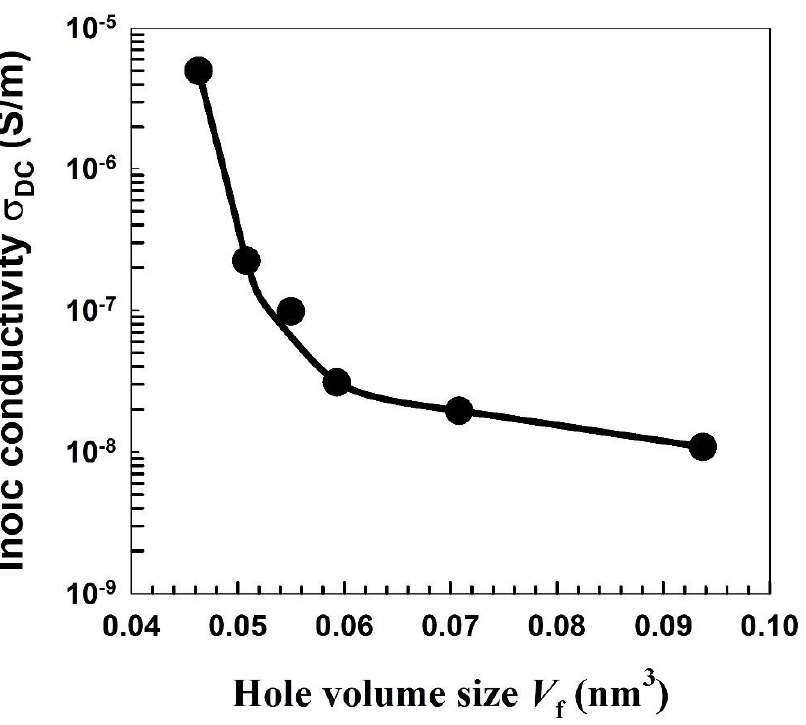
Figure 10. The correlation between the hole volume size V f and the DC ionic conductivity σ DC for the blend polymer (Nylon-6,6/PVA).